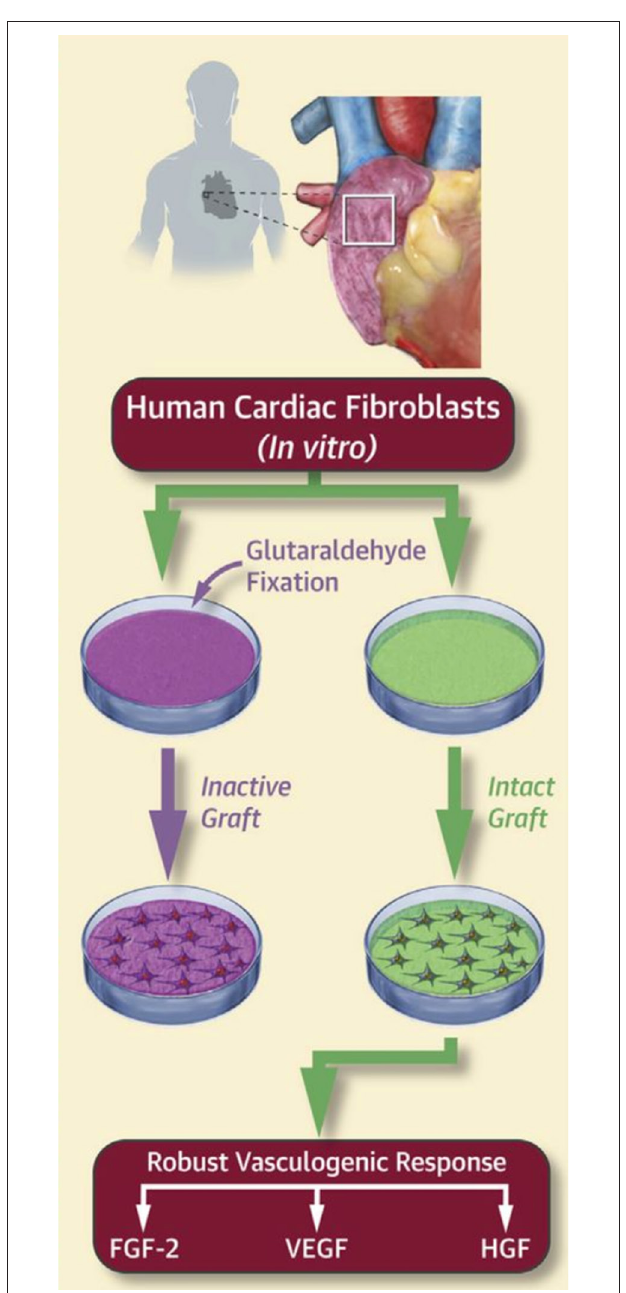
figURe 4 | Human cardiac fibroblasts isolated from right atrial appendage were seeded onto either bioactive ECM scaffolds (intact graft) or biologically inactivated scaffolds (inactive graft). Analysis of the conditioned media revealed that cardiac fibroblasts demonstrate a robust pro-vasculogenic response specific to the bioactive ECM scaffolds